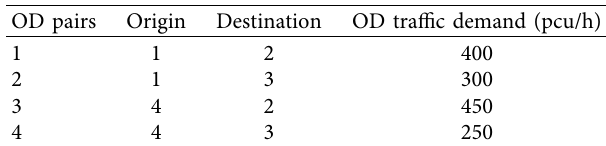
Table 2: OD traffic demand.